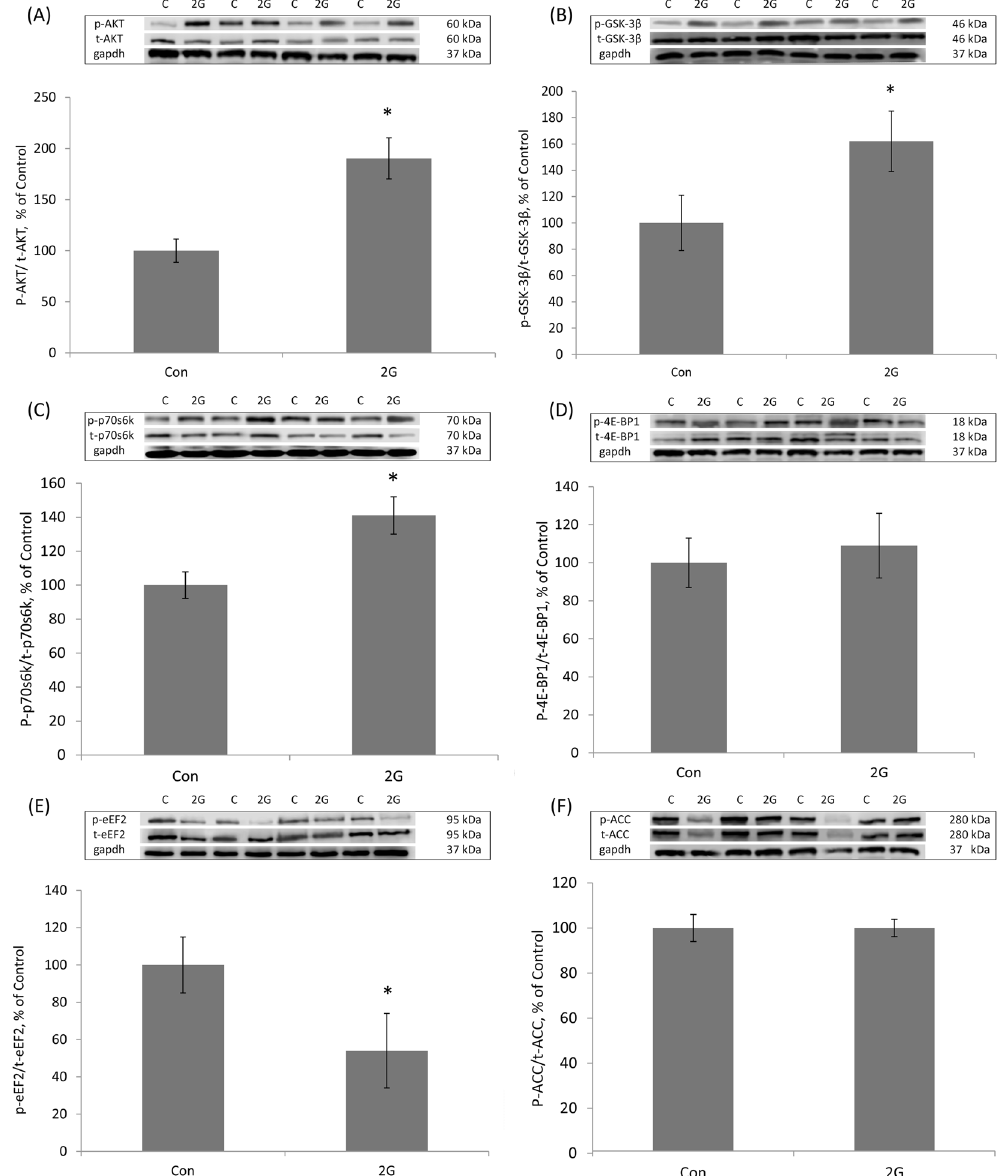
Figure 3. Phosphorylation status of the key anabolic signalling proteins in mouse tibialis anterior (TA) muscle following 30-day 2G centrifugation. ( A ) Quantification of phospho-AKT/total AKT ratio, expressed relative (%) to control. Representative blots are shown above the graph. ( B ) Quantification of phospho-GSK-3 β / total GSK-3 β ratio, expressed relative (%) to control. Representative blots are shown above the graph. ( C ) Quantification of phospho-p70s6k/total p70s6k ratio, expressed relative (%) to control. Representative blots are shown above the graph. ( D ) Quantification of phospho-4E-BP1/total 4E-BP1 ratio, expressed relative (%) to control. Representative blots are shown above the graph. ( E ) Quantification of phospho-eEF2/total eEF2 ratio, expressed relative (%) to control. Representative blots are shown above the graph. ( F ) Quantification of phospho-ACC/total ACC, expressed relative (%) to control. Representative blots are shown above the graph. Con – control mice, 2G – mice exposed to 30-day 2G centrifugation. * Significant difference from control (p < 0.05). All values are means ± SE, n =